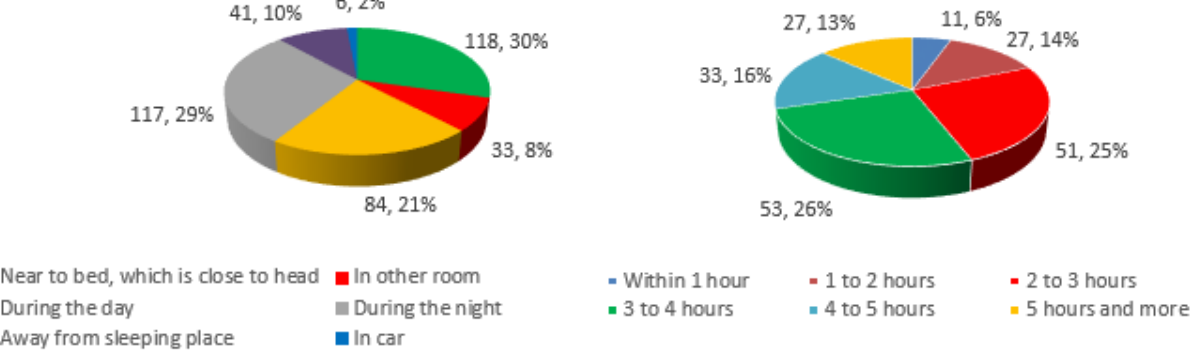
Figure 1. Phone position when charging Figure 2. Average daily time of using a phone